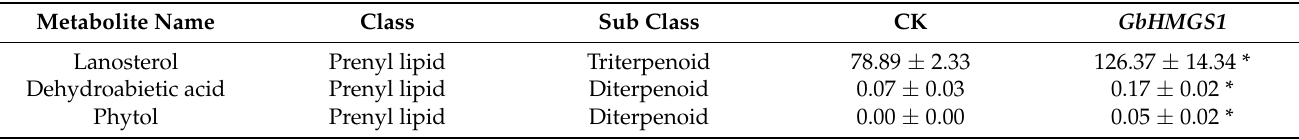
Table 2. Terpenoid contents in nontransgenic wild-type and transgenic plants. There is no unit for the expression value of the peak area of metabolites after internal standard normalization. * represents p < 0.05, as determined by one-way AVOVA with Duncan’s multiple range